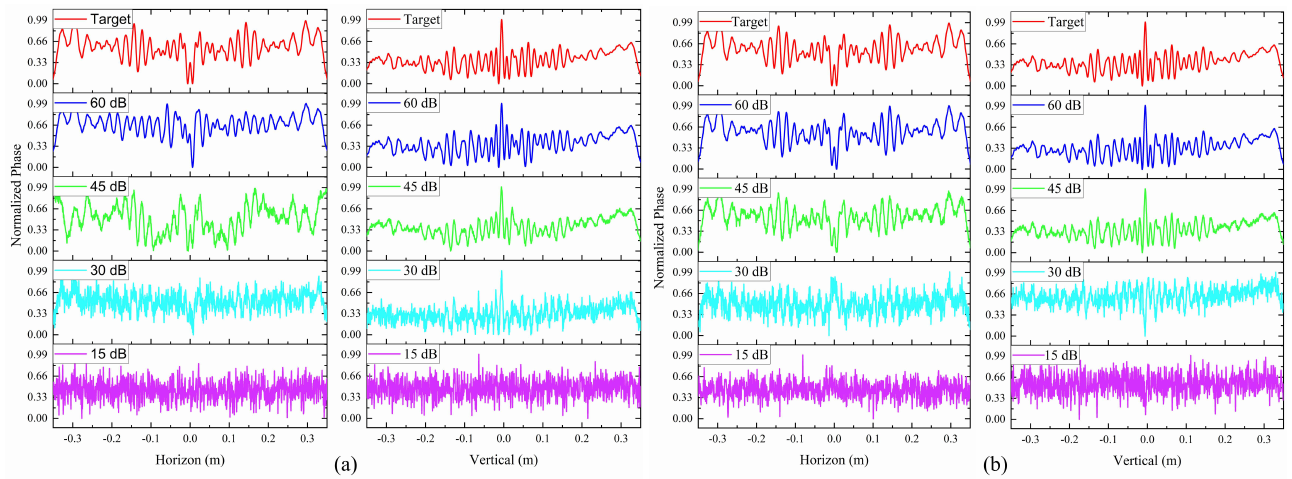
Figure 11. The comparison of the computational time of these algorithms at f = 220 GHz.